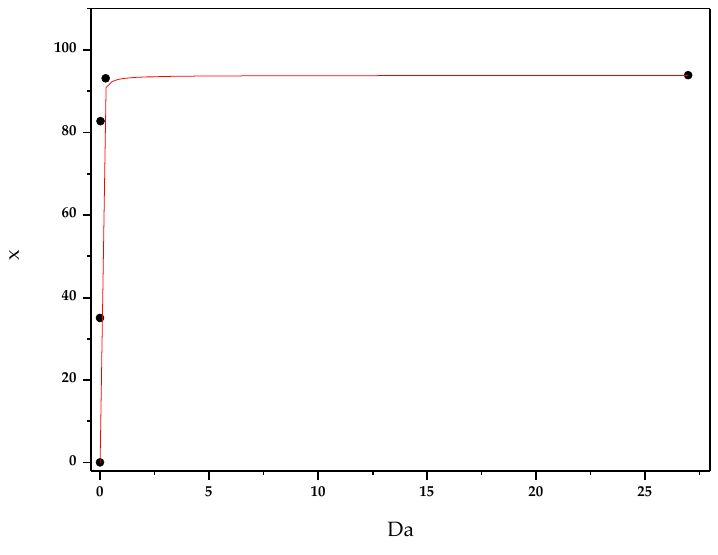
Figure 8. Molar concentration of cellobiose by varying mixture inlet velocity. ( A ) u in = 0.1297 m / s, ( B ) u in = 1.297 × 10 − 2 m / s, ( C ) u in = 1.297 × 10 − 3 m / s, ( D ) u in = 1.297 × 10 − 5 m / s.